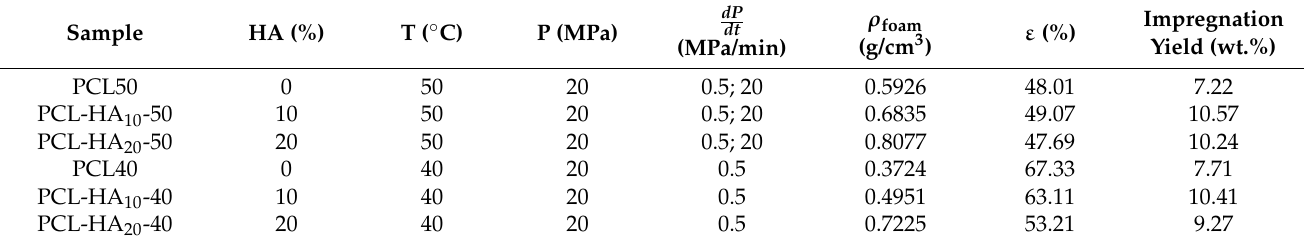
Figure 7. Scanning electron microscopy (SEM) micrographs of the neat PCL scaffold ( a , b ) and composite PLA scaffolds with different HA contents: 10 wt.% HA ( c , d ) and 20 wt.% HA ( e , f ) obtained at different temperatures. Table 2. Foam density, porosity and carvacrol impregnation yield of the impregnated PCL scaffolds with different HA contents obtained at different temperatures and decompression